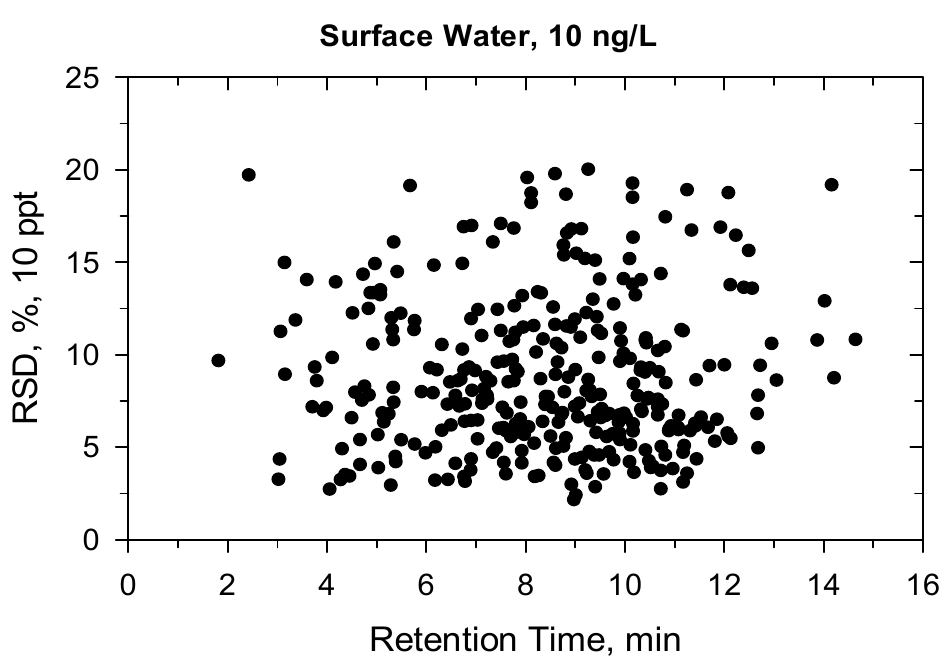
Figure 3. Recovery (%) versus retention time (min) at 10 ng/L in surface water.